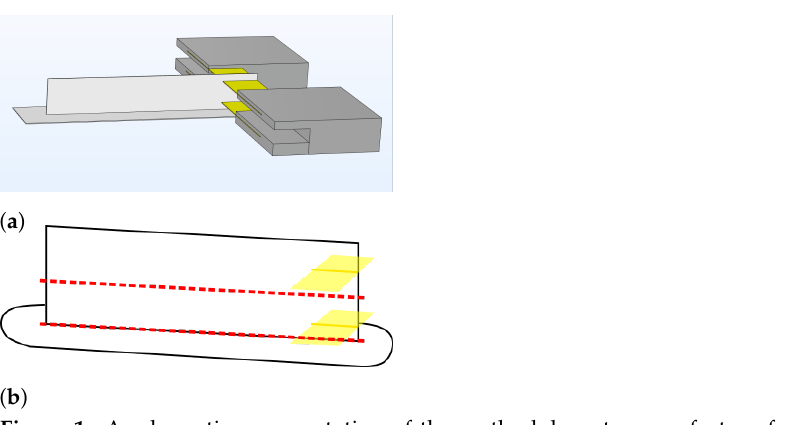
Figure 1. A schematic representation of the methodology to manufacture fracture test samples with ( a ) the wall geometry and brim (white), the PC Kapton tape holders (grey) and the strips of double-sided Kapton tape inserted to create pre-cracks (yellow) and ( b ) the printed wall specimen with Kapton tape strips (yellow) with the red dotted lines indicating where the sample will be cut to obtain two separate samples to test interlayer bond